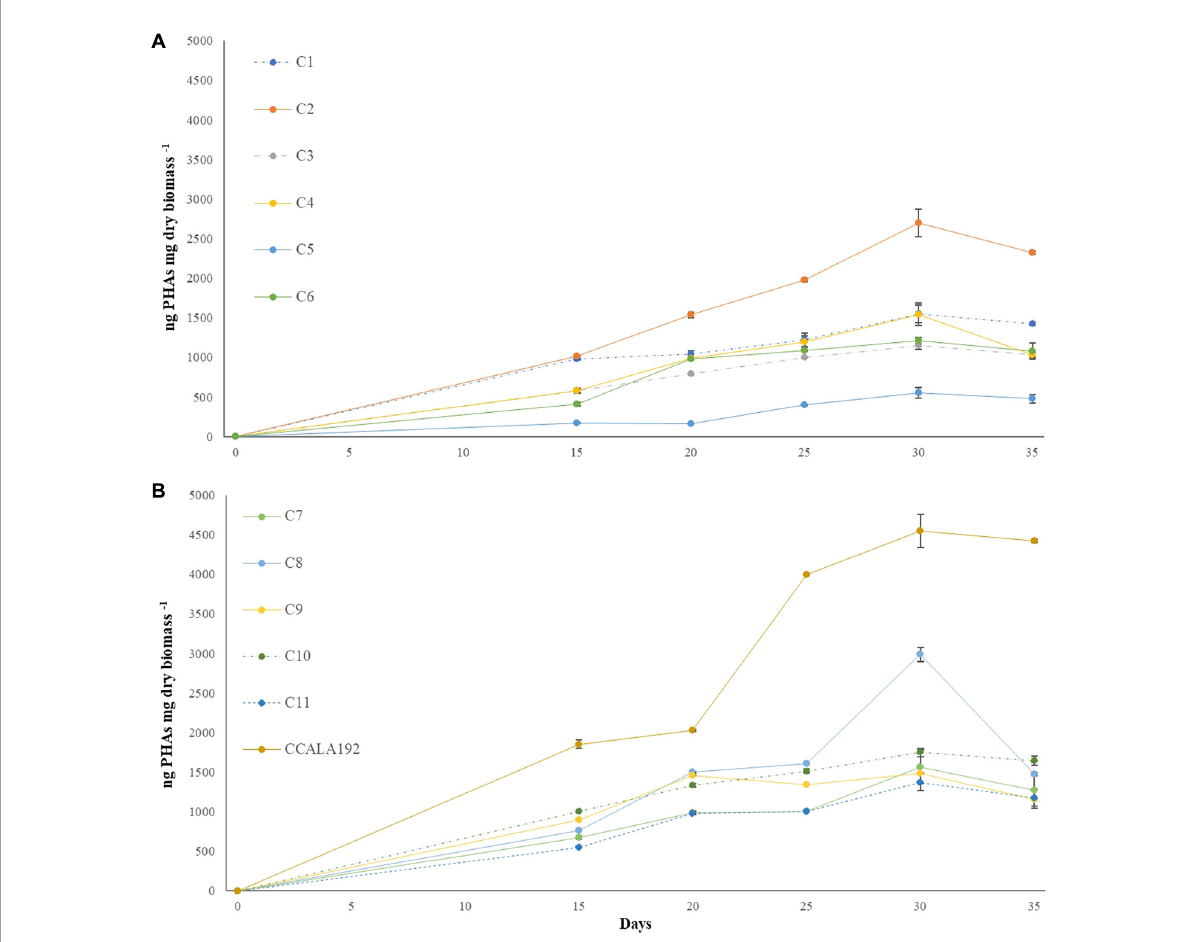
FIGURE4 Polyhydroxyalkanoates production curves recorded for “Stiffe” caves’ cyanobacteria and Synechocystis cf. salina , grown in BG11 modified for starvation. (A) C1-C6 curves; (B) C7-C11 and CCALA192